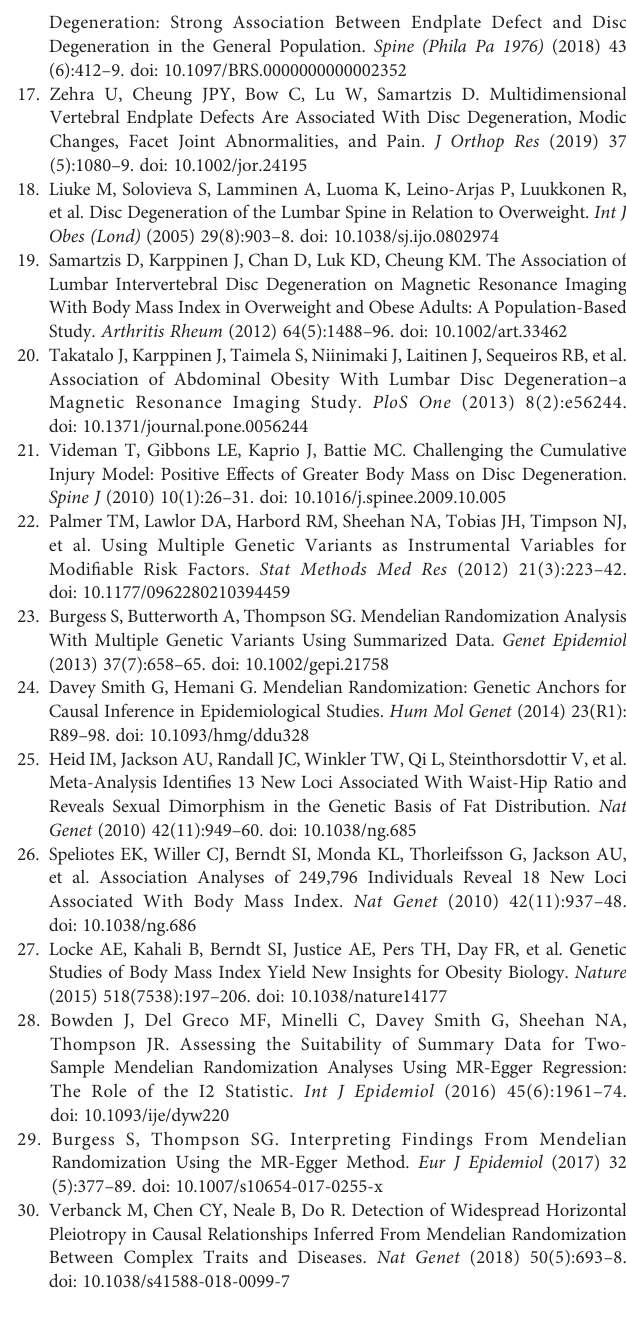
Supplementary Table 3 | Results from sensitivity